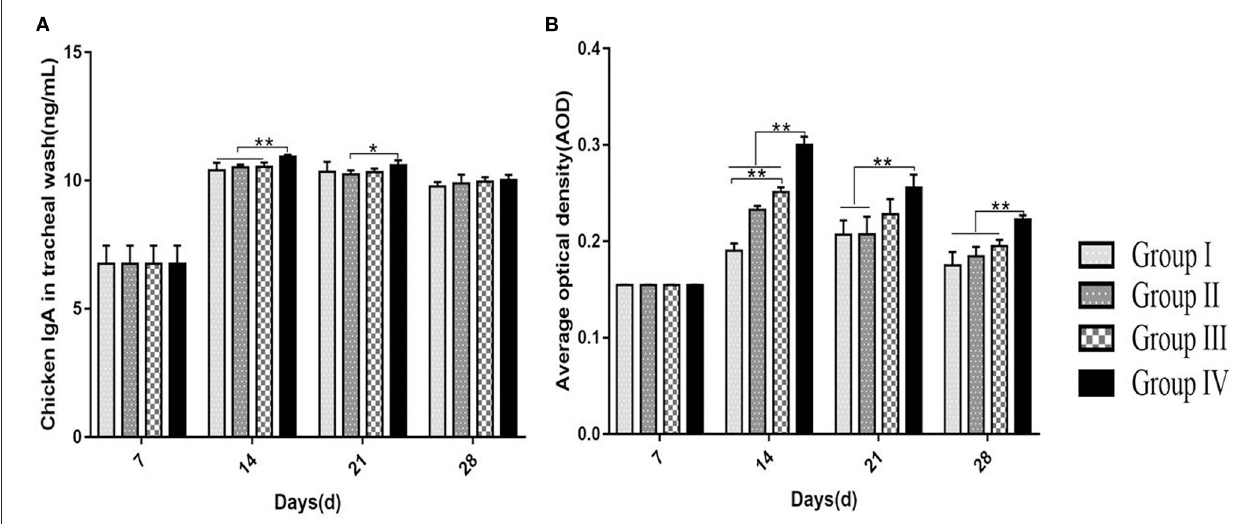
FIGURE 2 | Effect of doxycycline or SGDL granule and both on IgA concentration in tracheal washing using ELISA kit (A) and AOD using ImageJ analysis of the expression of IgA + cells in the tracheal mucosa of chicken (B) . Group I served as a control. Broilers in Group II were given doxycycline whereas Group III was given SGDL granule through drinking water. Broilers in Group IV were given SGDL granule and doxycycline in drinking water. Extremely significant ( p < 0.01) different values are shown with **. Significantly ( p < 0.05) different values are shown with *, and no signal was not significantly ( p > 0.05) different between the groups at those time points. SGDL, Shegandilong.